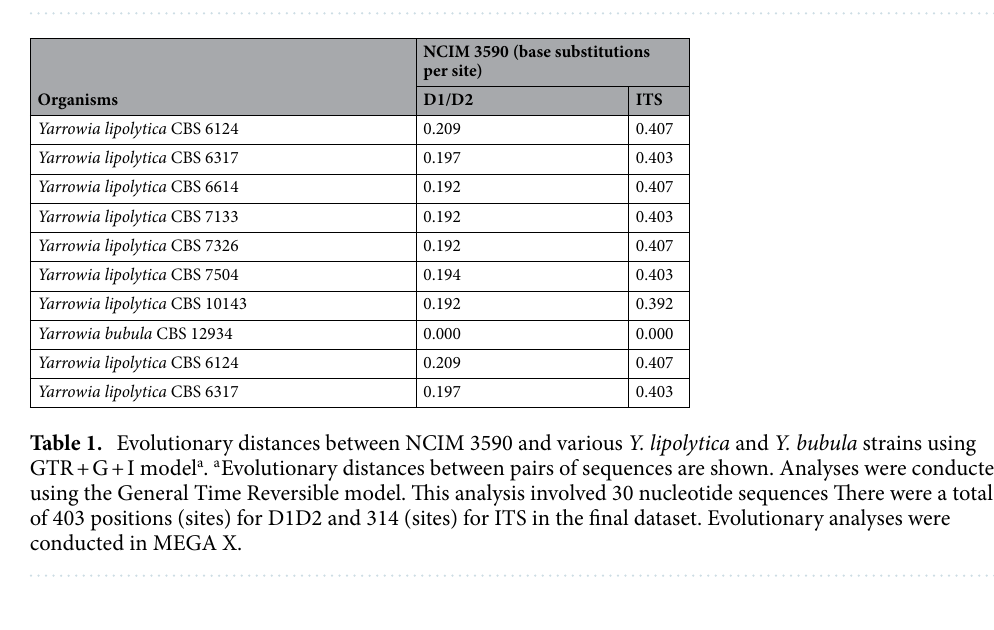
Figure 1. Phylogeny of NCIM3590. The phylogenetic tree analysis by maximum likelihood (ML) method showing the placement of NCIM 3590 and related species based on the analysis of ( a ) internal transcribed spacer (ITS) regions and ( b ) D1/D2 domains of the large subunit rRNA gene. The ML tree was obtained using the GTR + G + I model. The tree with the highest log likelihood is shown. The tree is drawn to scale with branch lengths measured in the number of base substitutions per site. All positions containing gaps and missing data were eliminated. Blue box represents Y. lipolytica as single clade/group and green as Y. bubula as single clade/ group.